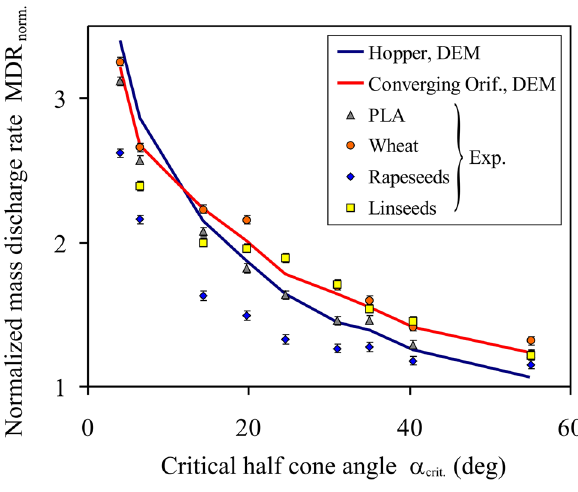
Figure 4. Comparison of the experimental and DEM simulated values of the normalized mass discharge rate MDR norm. obtained for different alues of the critical half cone angle α crit. .